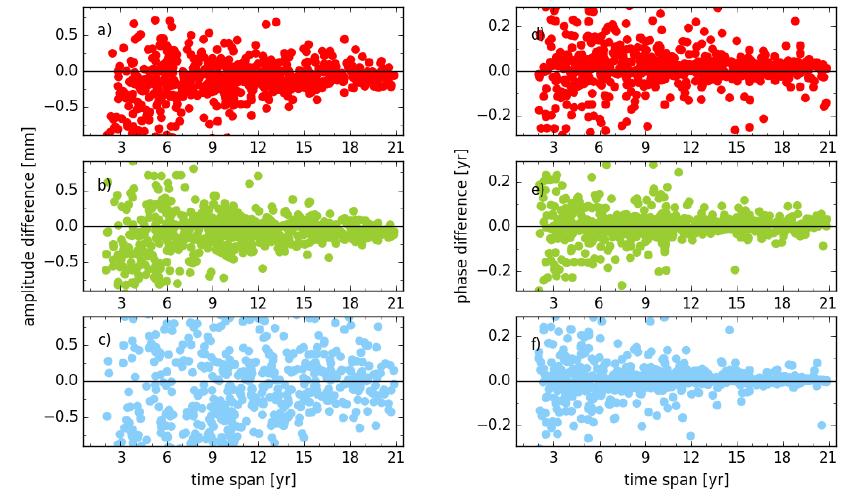
Figure 5. Amplitude and phase differences of annual signal between solution cova_tr_s2 and cova_tr_s2d2 for stations with different observation time spans; ( a , d ) for east; ( b , e ) for north; ( c , f ) for vertical components.